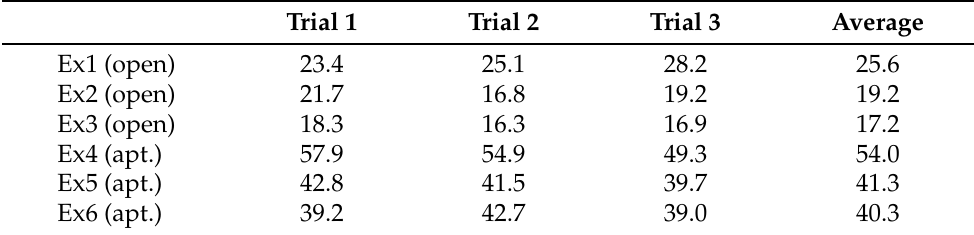
Figure 8. Tracking accuracy of the system in Ex6.3. In the figure, the ground truth coordinates are shown using ( ), the estimated with ( ) and the pink area illustrates the 3 σ confidence interval of RTI position estimates. Table 3. RMSE in centimeters of the proposed system in the different experiments and